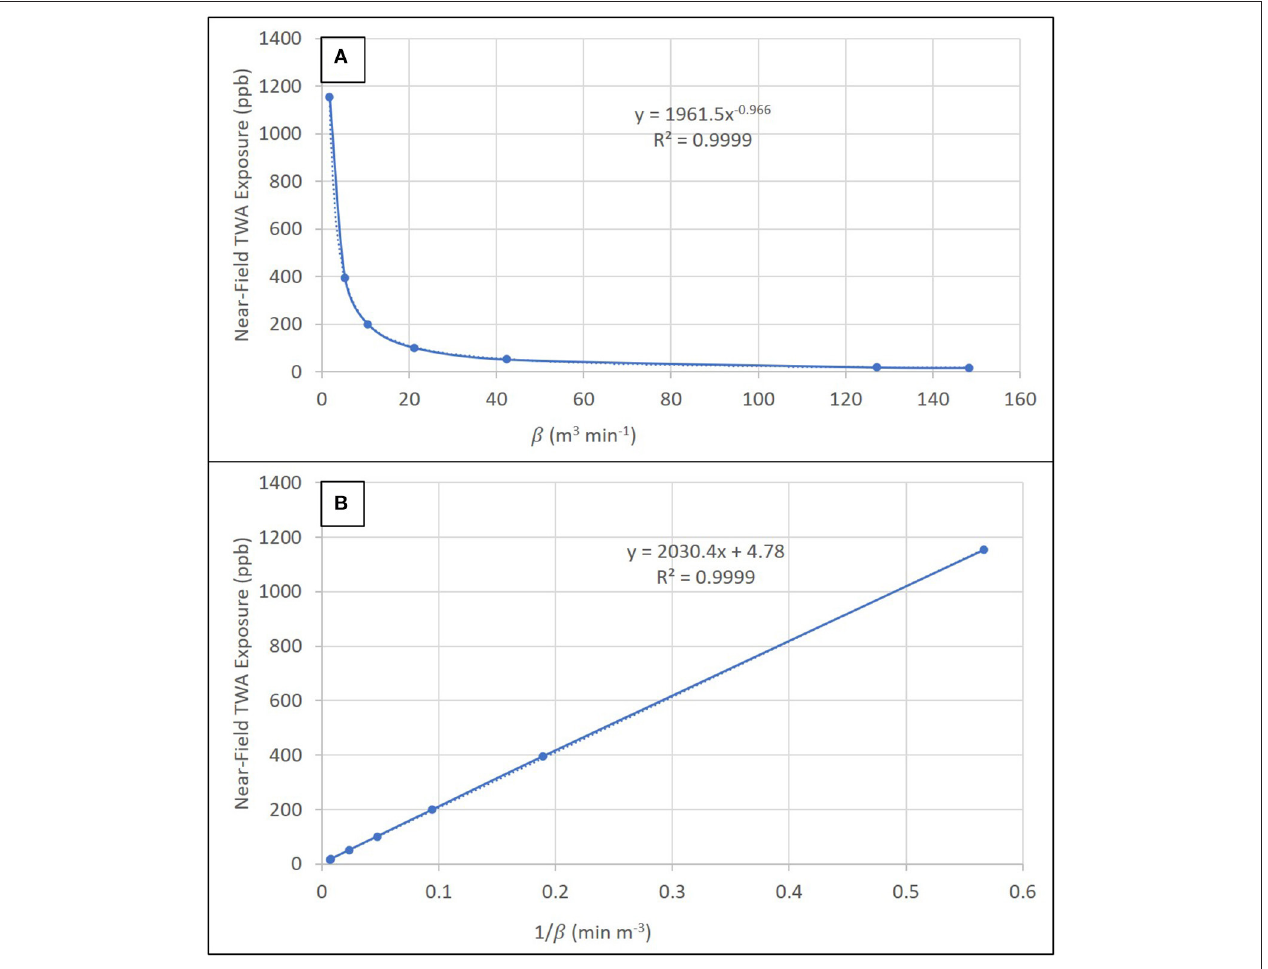
FIGURE 5 | Sensitivity analysis showing the trend in near-field TWA exposure concentration as a function of (A) the inter-zone air flow rate ( β ) and (B) 1 /β